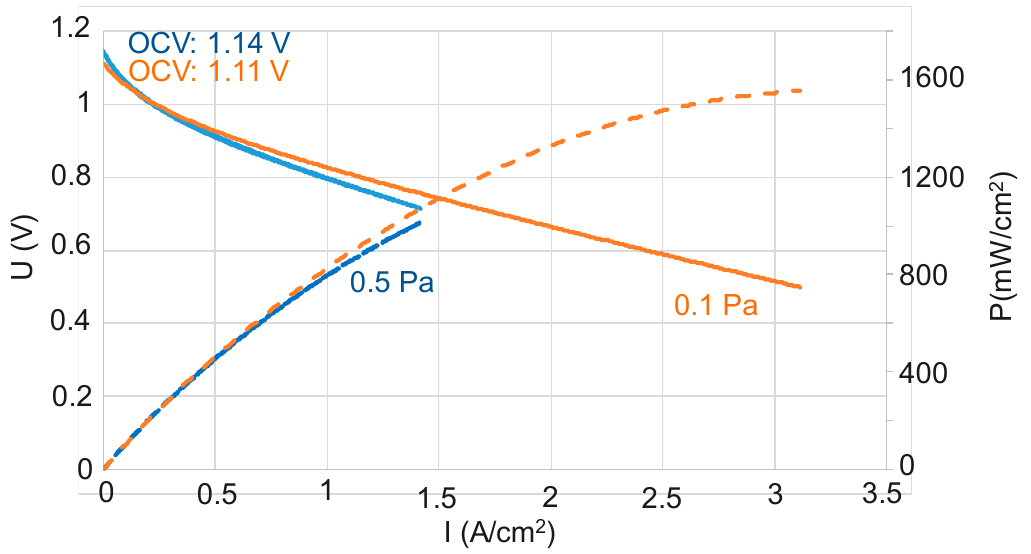
Figure 3. Potential and power versus current of a 2R-Cell™ equipped with a GDC buffer layer deposited via reactive magnetron sputtering under 0.1 and 0.5 Pa.